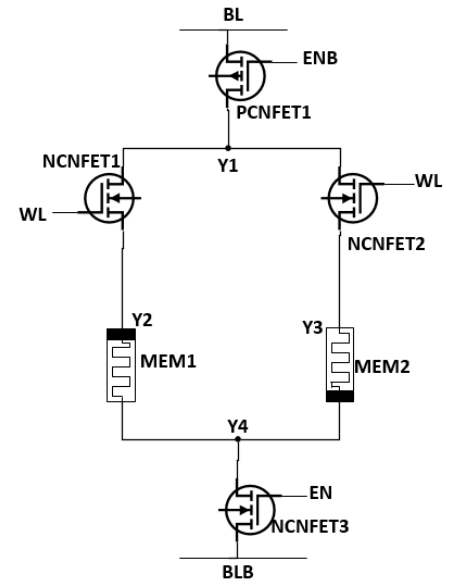
Figure 5. High reliability read–write circuit based on memristor(HRC) [27]. During the write operation, WL and EN are set as the power supply voltage VDD, while ENB is set as GND to turn on transistors NCNFET1, NCNFET2, NCNFET3, and PCNFET1. When BL remains at VDD, that is, when BLB remains at GND, the current flows from node Y1 to node Y4, then both ends of memristor M1 are forward voltage and both ends of memristor M2 are reverse voltage, so M1 is in a low resistance state. Logic